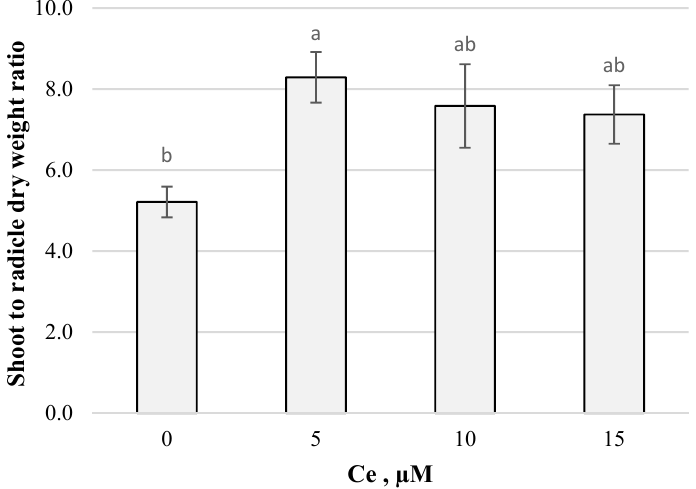
Figure 5. Shoot to radicle dry weight ratio of tomato ( Solanum lycopersicum L.) cv. Vengador seedlings after seven days in germination chambers in solutions with different Ce concentrations. Means ± SDs with different letters indicate significant statistical differences (LSD, 0.05).